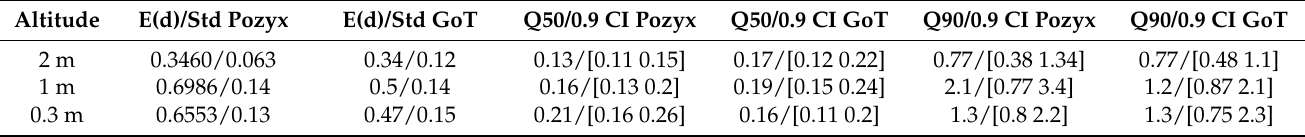
Table 2. Mean and median error distances for different altitudes. (Mean distance: E(d), Quantile: Q., Confidence interval: